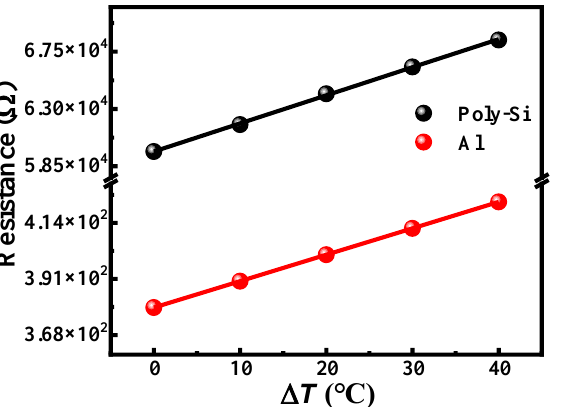
Figure 4. Variation of resistance of design salicide polysilicon and metal Al microbolometers with temperature difference range of 0 – 40 °C. The lines represent the linear fitting results by Equation (2).